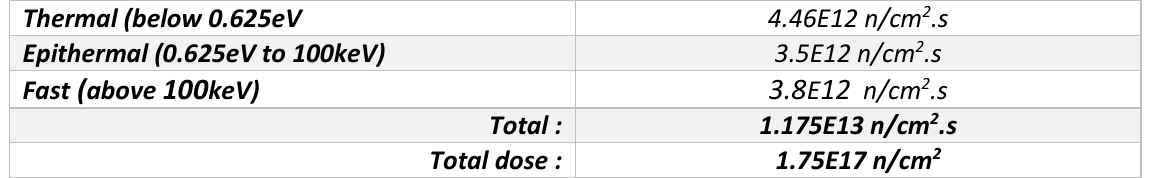
Fig. 6 : calculated neutron flux for JSI facilities